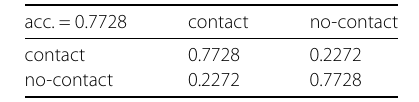
Table 1 Confusion matrix with accuracy for logistic regression to reconstruct binary